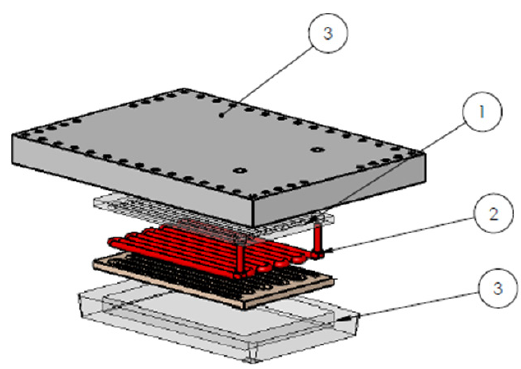
Figure 3. Heat system assembly on the mold: (1) aluminum plates, (2) resistance and (3) mold parts.